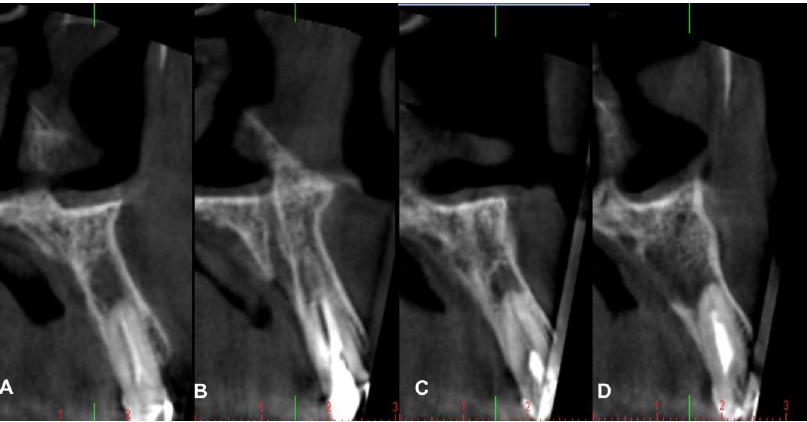
Figure 14. Previous CBCT. ( A ) 12 ( B ) 11 ( C ) 21 ( D ) 22.